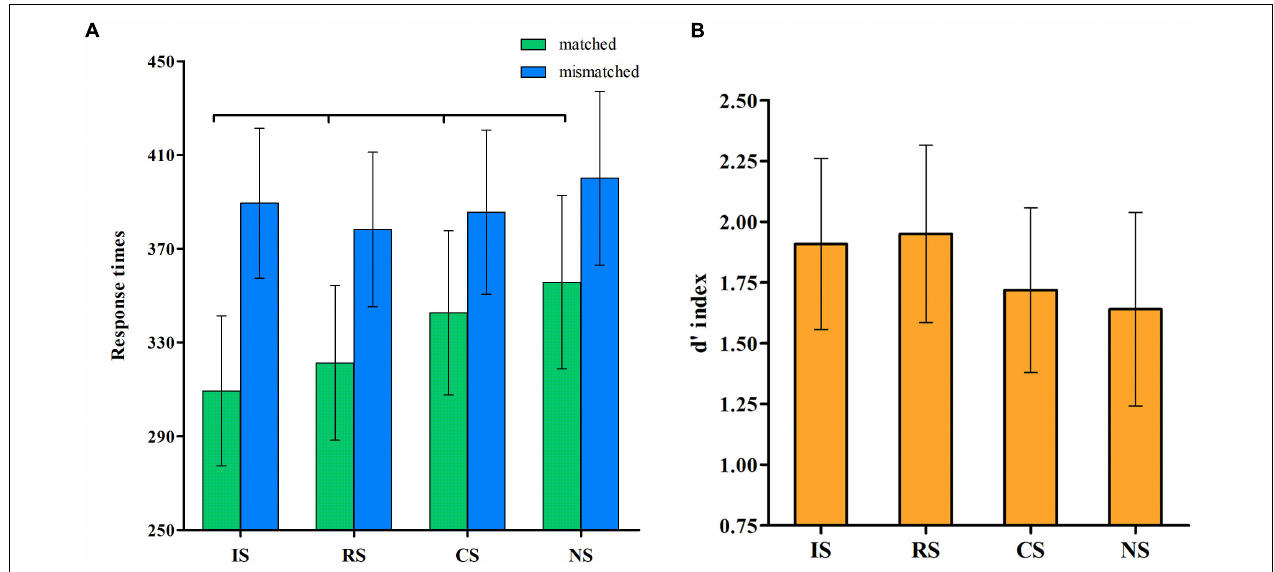
FIGURE 1 | Self-association effect. (A) Shows the mean response times of the matched and mismatched pairs for the different selves. (B) Shows the d ’ index for the different selves. TABLE 2 | Mean amplitudes of P2, N2, P3, and LPC of the self variables in the matched condition. Frontal Frontal-central Central Central-parietal Parietal